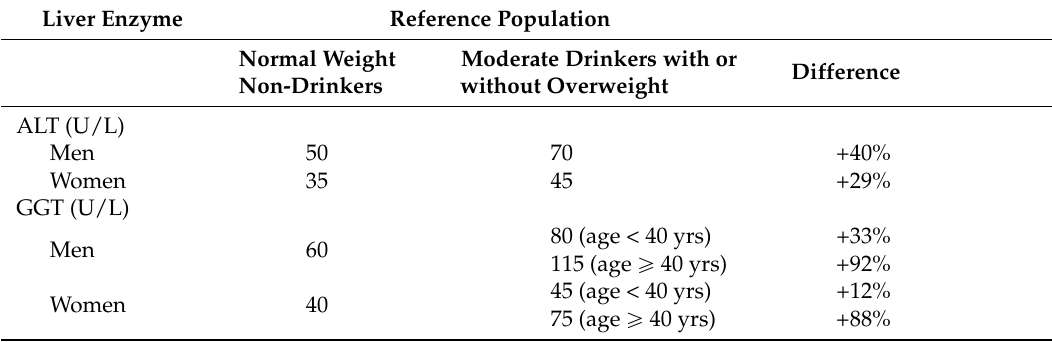
Table 6. Comparison of upper limits of normal (ULN) of two liver enzymes based on two different types of reference